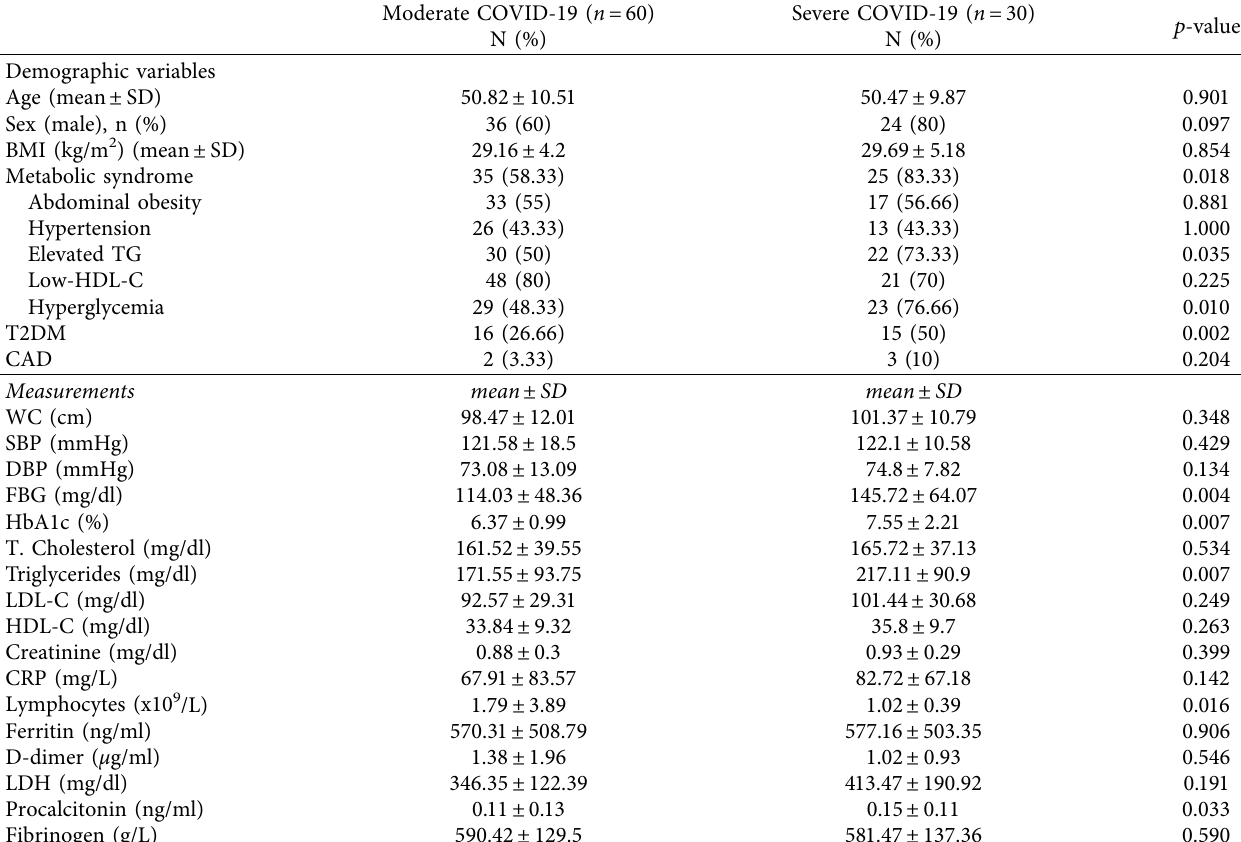
Table 1: Patients’ characteristics of moderate and severe COVID-19